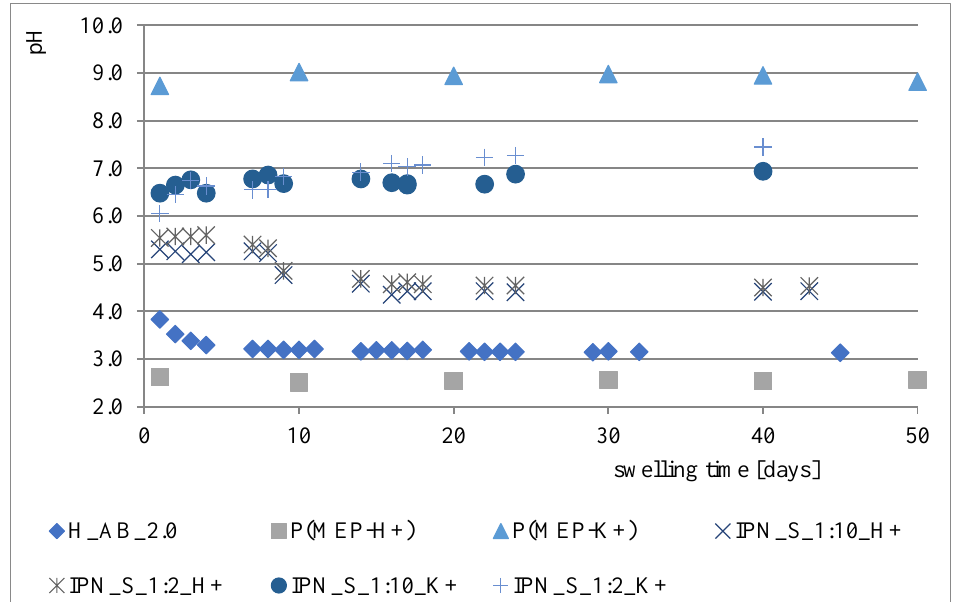
Figure 8. Changes in pH of the solutions above particular polymers.